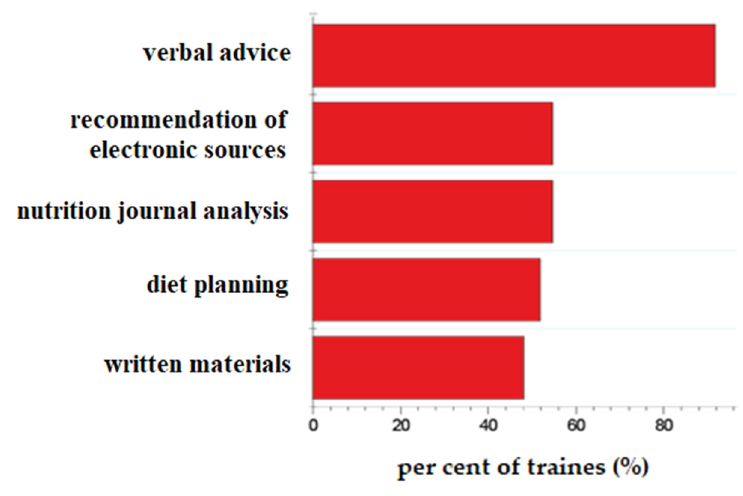
Figure 5. Form of nutrition related advisory activity.